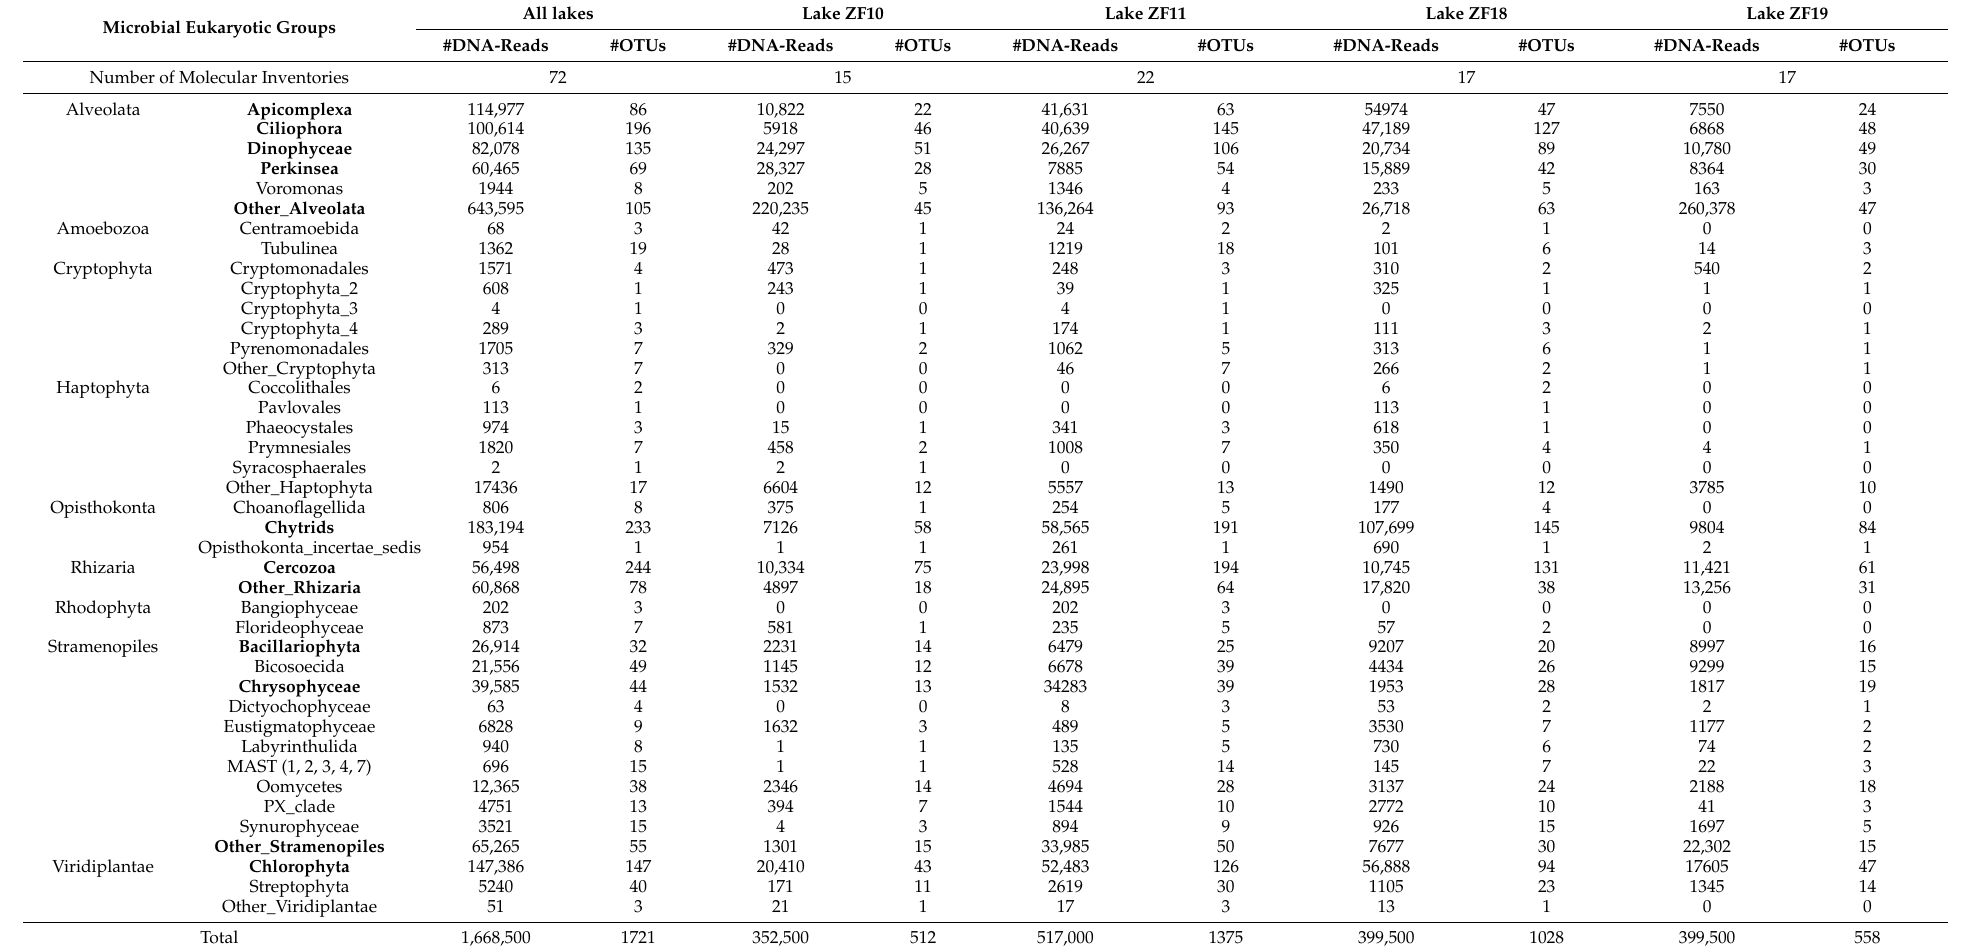
Table 2. Number of DNA reads (#DNA-reads) and Operational Taxonomic Units (OTUs) (#OTUs) for each microbial eukaryotic group detected in all samples and for each lake independently. The 12 most dominant microbial eukaryotic groups are highlighted in